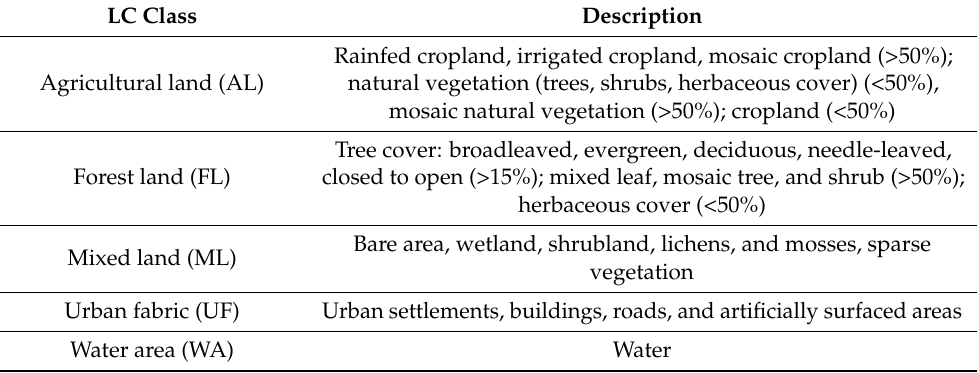
Figure 2. Overall technical flowchart in this study. ESA, European Space Agency; CCI, Climate Change Initiative; LC, land cover; LCU, land cover/use; LST, land surface temperature; SUHI, surface urban heat island; SUHII, SUHI intensity. Table 1. LC thematic legend in this